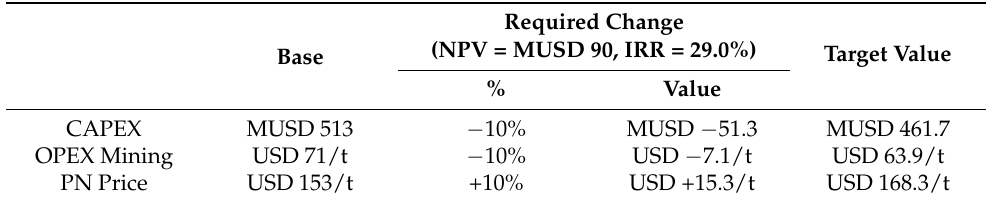
Table 15. Scenario of simultaneous change of key variables (scenario